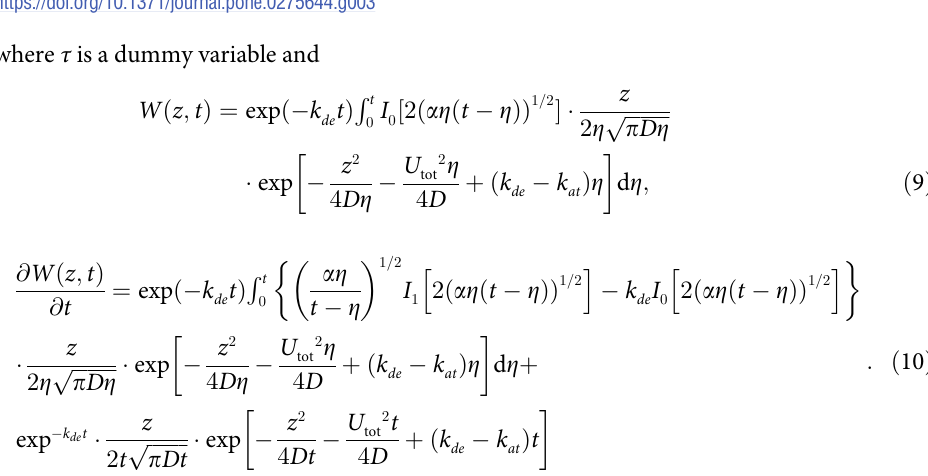
Fig 3. Conceptual diagram of the particle migration in porous media considering